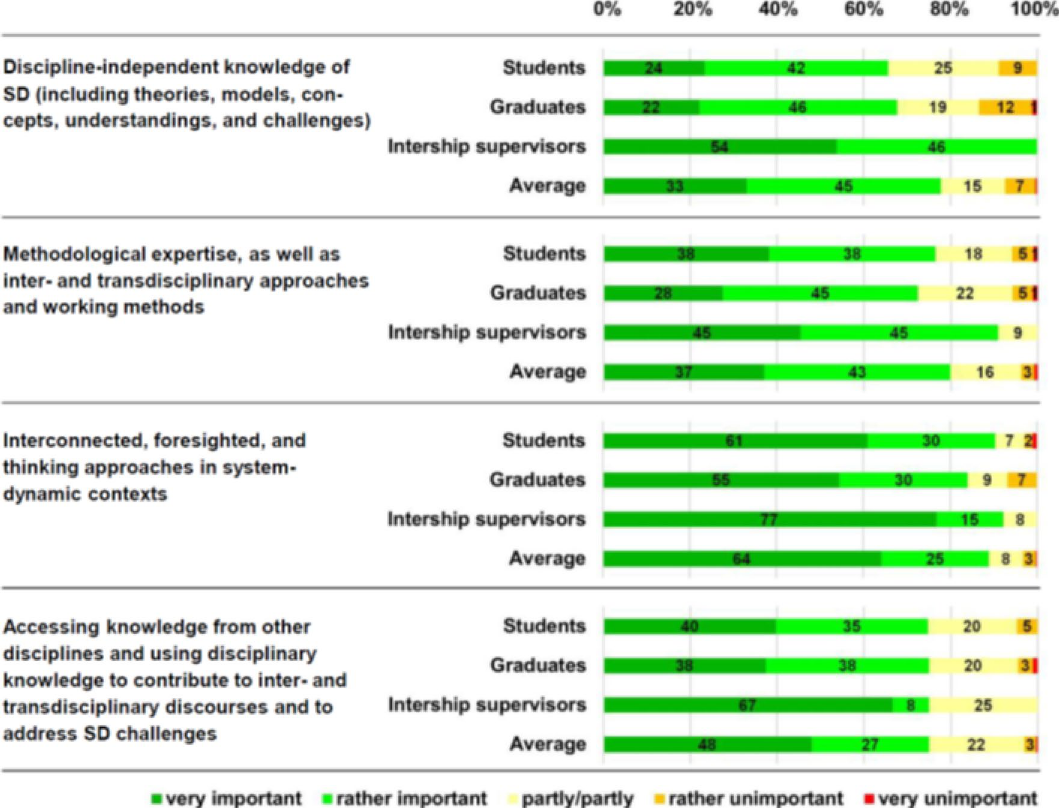
Fig. 1 Assessment regarding the importance of fostering specialized and methodological competencies from the perspective of students, graduates, and internship supervisors, as well as the average of the three estimations in % (students are N = 102/102/105/103 from top to bottom; graduates N = 90/87/88/88; and internship supervisors N =